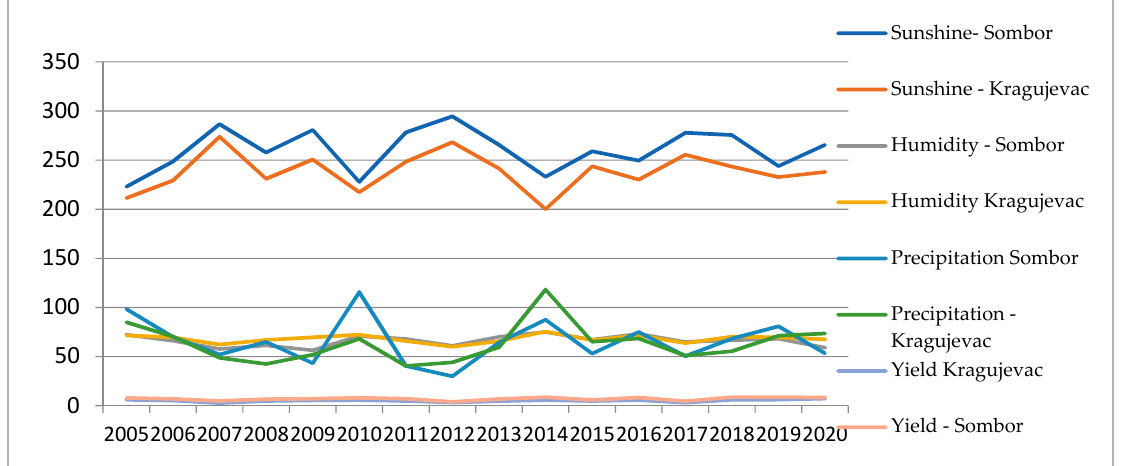
Figure 9. Variation Yield and purchase price of maize in the Republic of Serbia for the period 2005–2020. Based on the average values of six variables for a period of 16 years and the values of standard deviation, the descriptive analysis found that the average yield of maize in Vojvodina (7000 kg ha − 1 ) is significantly higher than Central Serbia (5000 kg ha − 1 ), as and deviations (1500 kg ha − 1 ) that are larger than the area of Central Serbia (1200 kg ha − 1 ) Table 1. Descriptive analysis of the space of the Republic of Serbia for the time period 2005–2020. Mean Std. Deviation